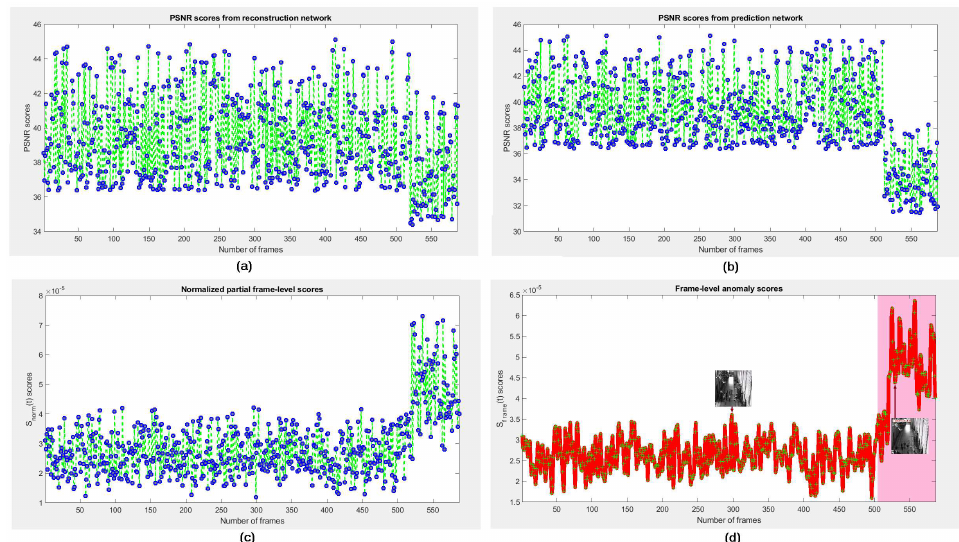
Figure 17. A sample output using UMN [36], where a sudden crowd panic and run was happened. ( a , b ) exhibit PSNR scores, whereas ( c , d ) show frame-level scores.